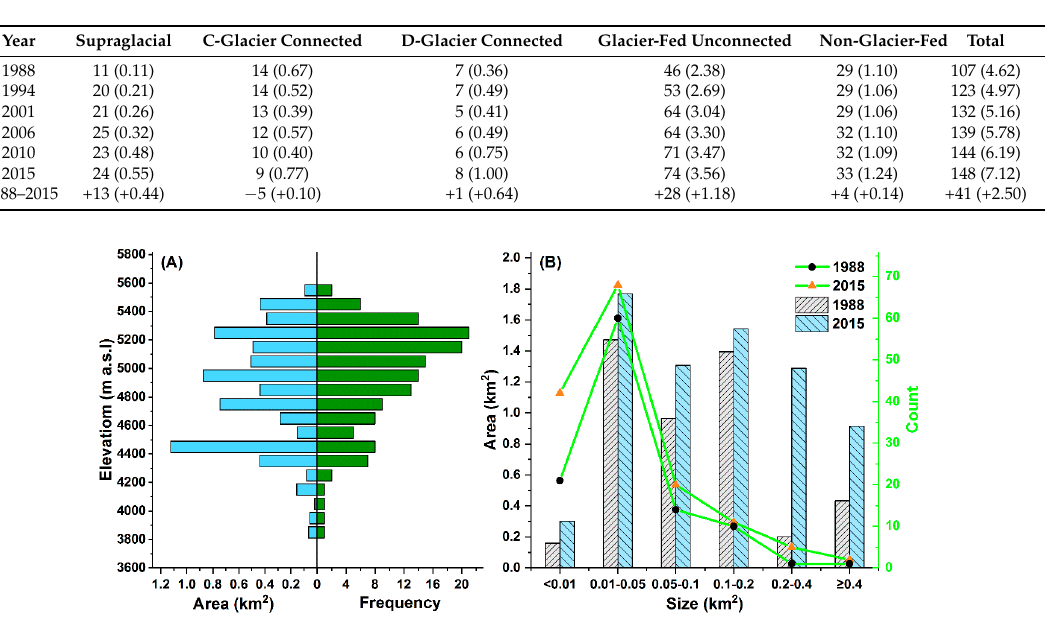
Table 6. Comparison of glacier changes by their connection with or without glacial lakes.